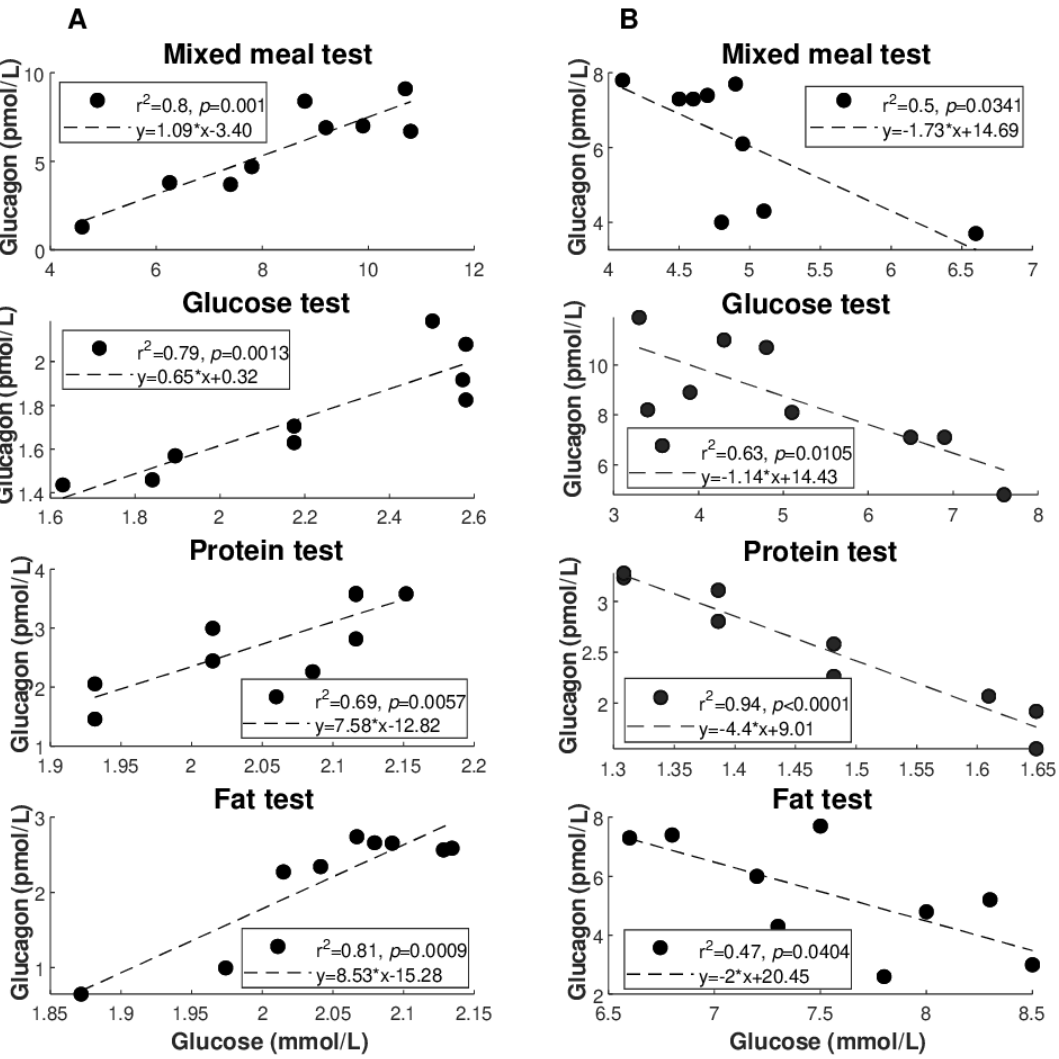
Figure 2. Best regression (highest R 2 value) between glucagon and glucose for each of metabolic tests in individual regression analysis (( A ) direct regressions; ( B ) inverse regressions). Values are log-transformed in following cases: glucose, protein, and fat tests in ( A ); protein test in ( B ).